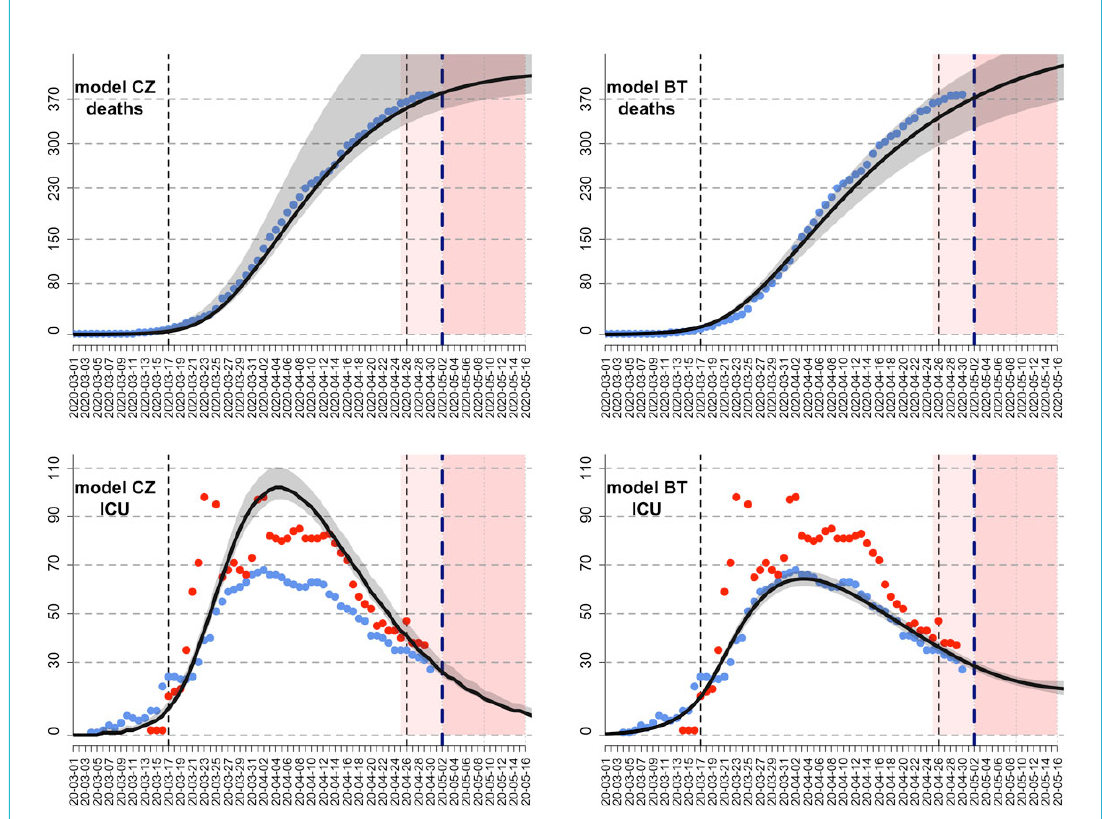
Figure 1: Canton-level fit of epidemic models CZ and BT in Vaud on 03 May 2020. Grey shading represents 95% CIs, red dots are ICU occu- pancy as reported in the IES systems, and blue dots are ICU occupancy as reported by OpenZH. The BT model is fitted to deaths and ICU oc- cupancy times series from OpenZH, whereasthe CZ models is fitted only to deaths.